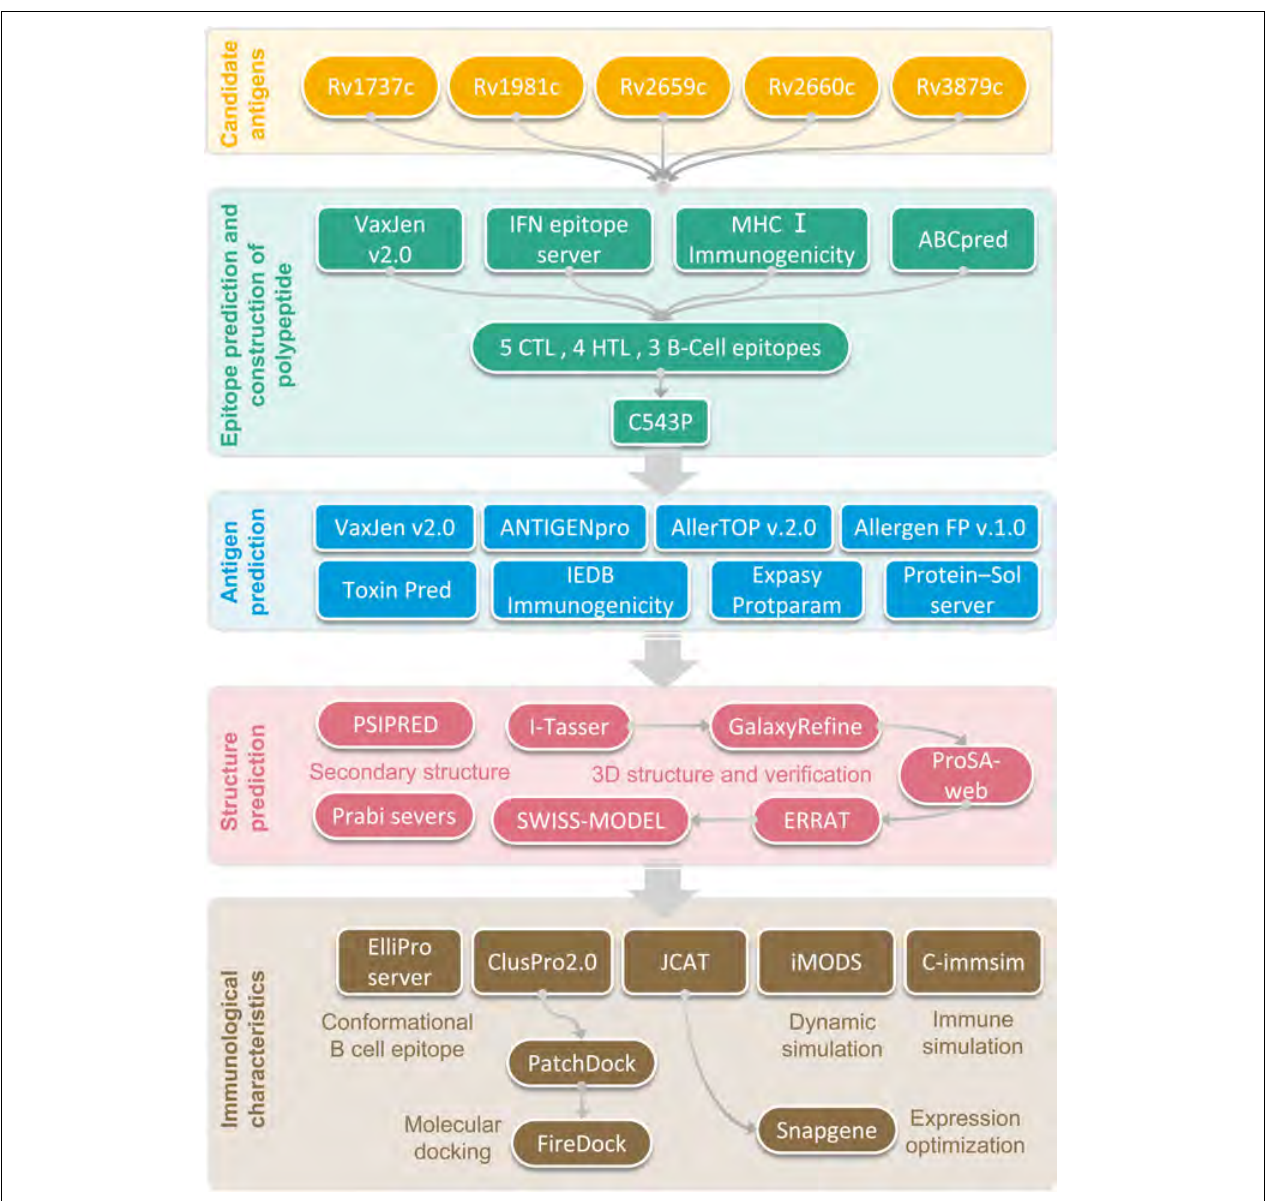
FIGURE 1 | Flow chart of epitope prediction, screening, construction, and PPM